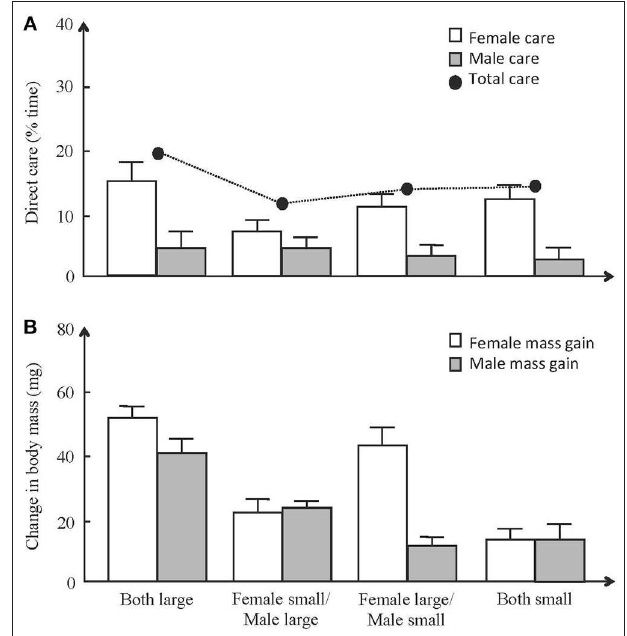
FIGURE 1 | Effects of male and female body size on the amount of care and weight change during breeding of male and female parents in the burying beetle Nicrophorus vespilloides . (A) Mean ± SE amount of time spent providing direct care by females (open bars) and males (gray bars). The total amount of care offspring received from both parents (filled circles) is shown for each treatment (mean). Parents provided less care when their partner was small (females: – Z = 2.3, p = 0.022; males: – Z = 2.2, p = 0.026). (B) Mean ± SE weight change (mg) over the reproductive attempt for small and large males (black bars) and small and large females (gray bars). Males gained more mass when mated to a large female ( t = − 3.2, p = 0.002), whilst females gained more mass when partner gained more mass ( t = − 3.2, p = 0.047). Used with permission from John Wiley and Sons (A) and Elsevier (B)